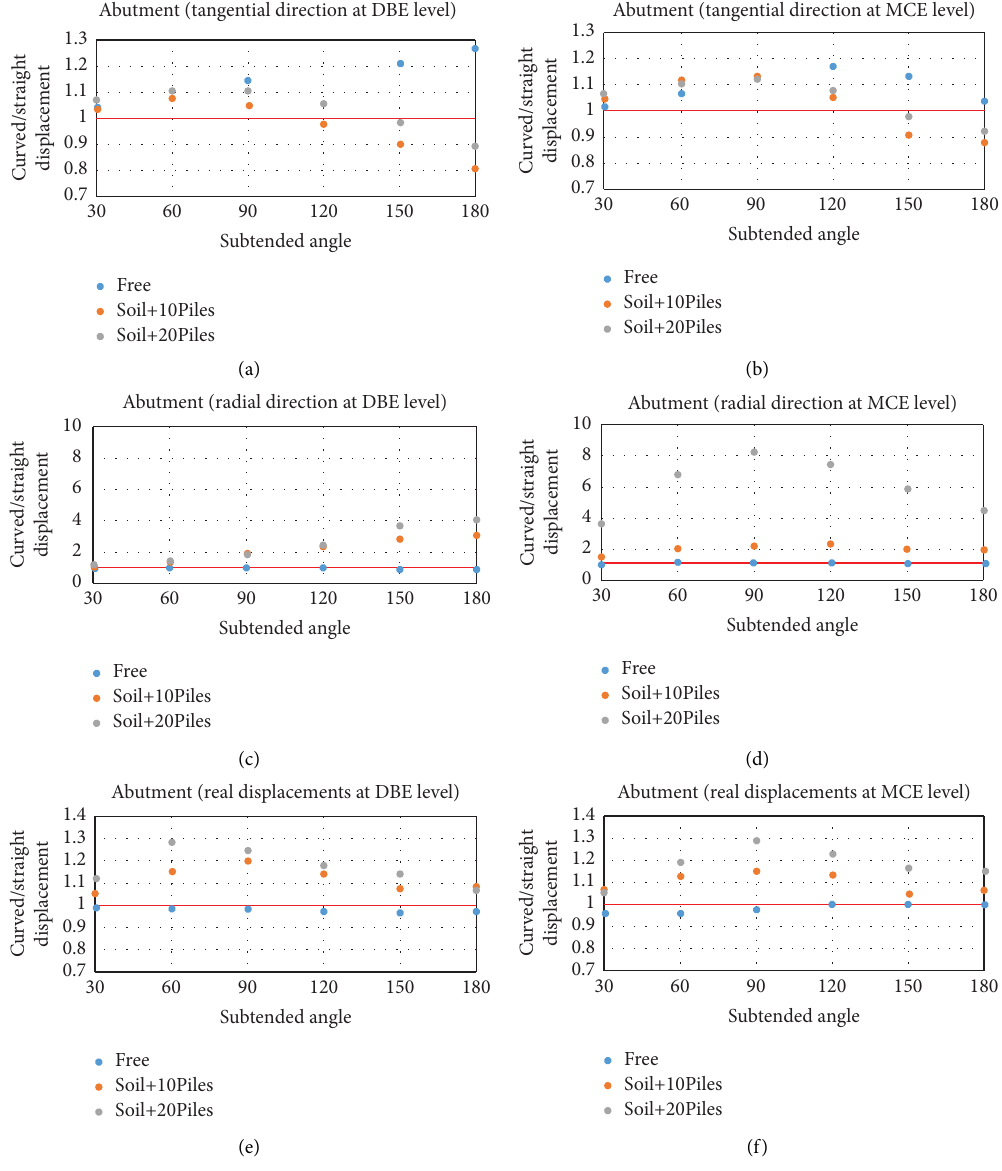
Figure 25: Curved/straight deck displacement ratios at abutments predicted in the tangential direction at (a) DBE, (b) MCE levels; ratios predicted in the radial direction at (c) DBE, (d) MCE levels; ratios predicted using real displacements at (e) DBE, (f) MCE levels.